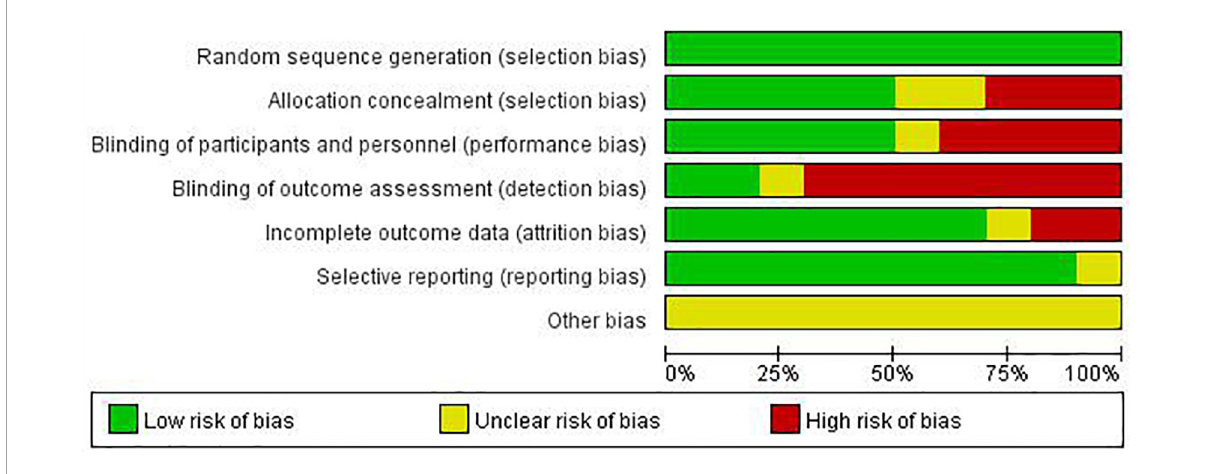
FIGURE2 Risk of bias